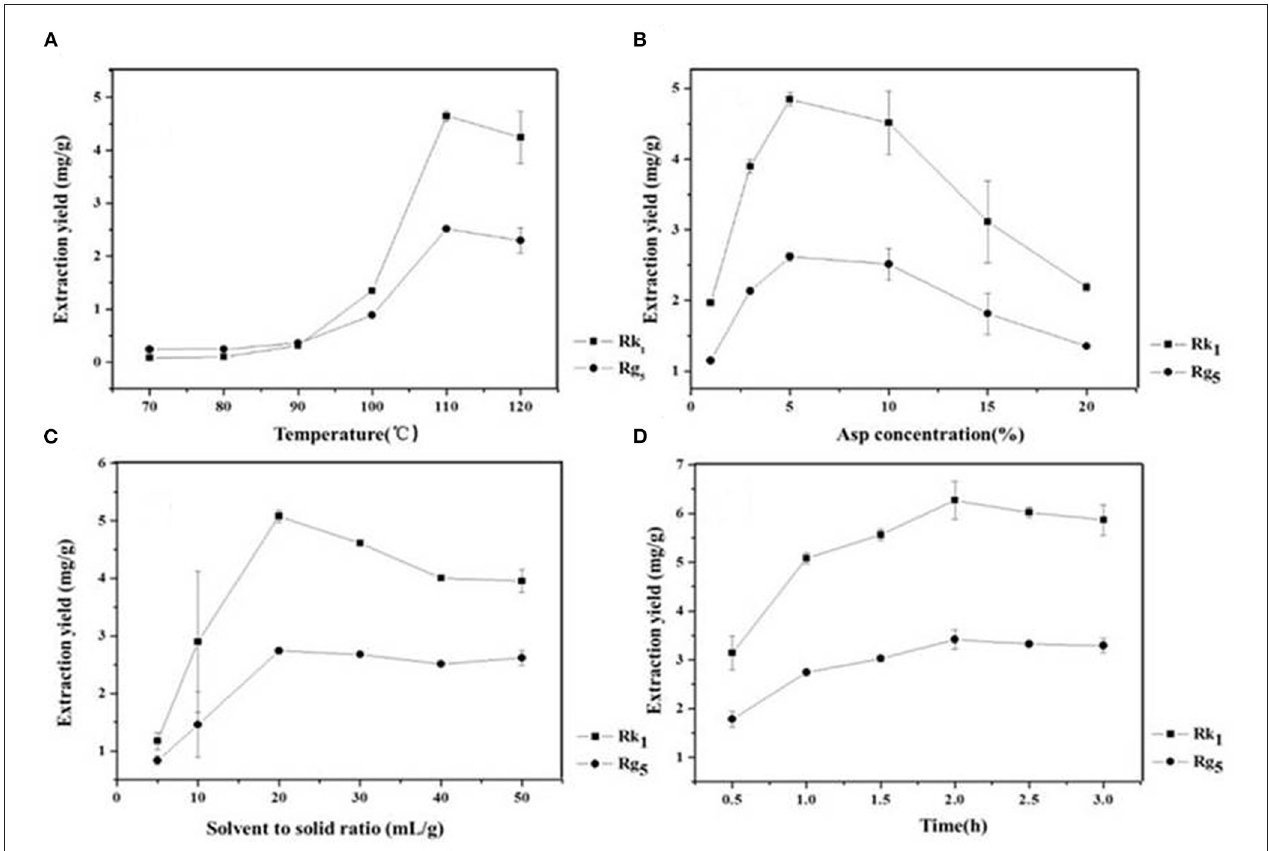
FIGURE 2 | Effect of reaction (A) temperature (B) Asp concentration (C) liquid-solid ratio and (D) reaction time on the conversion content of rare ginsenosides Rk 1 and